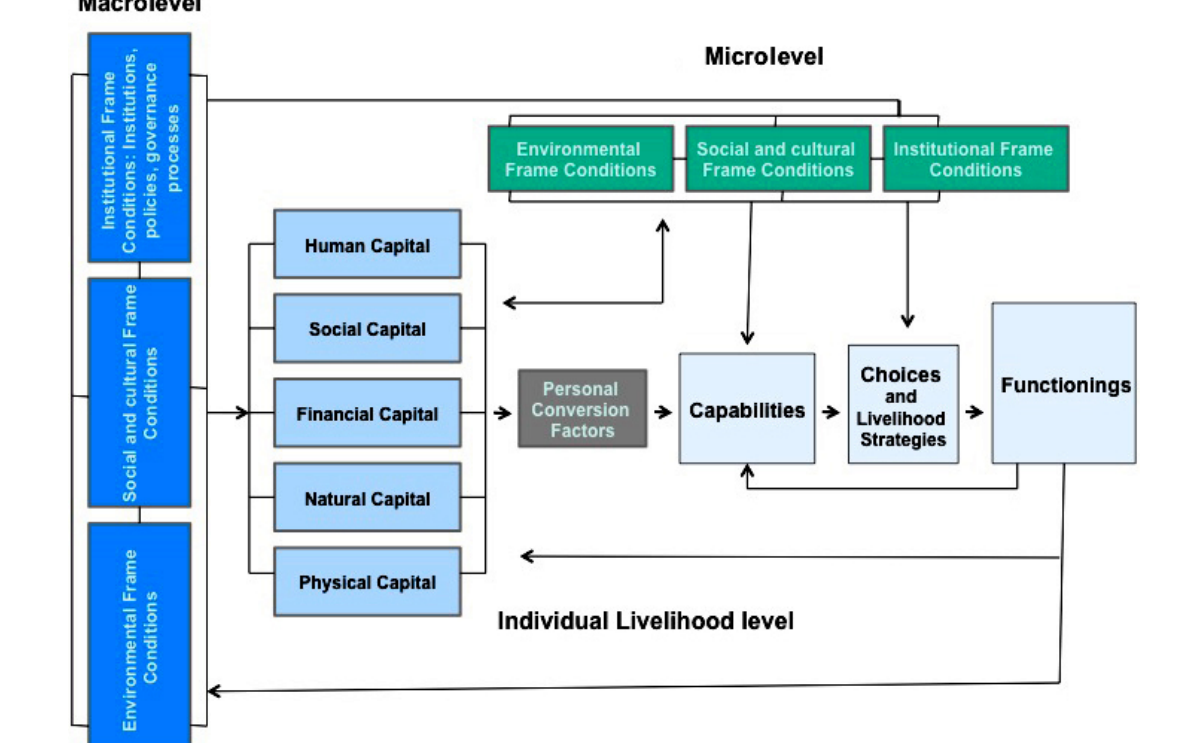
Fig. 1 . A livelihood-based capabilities framework from a sustainability